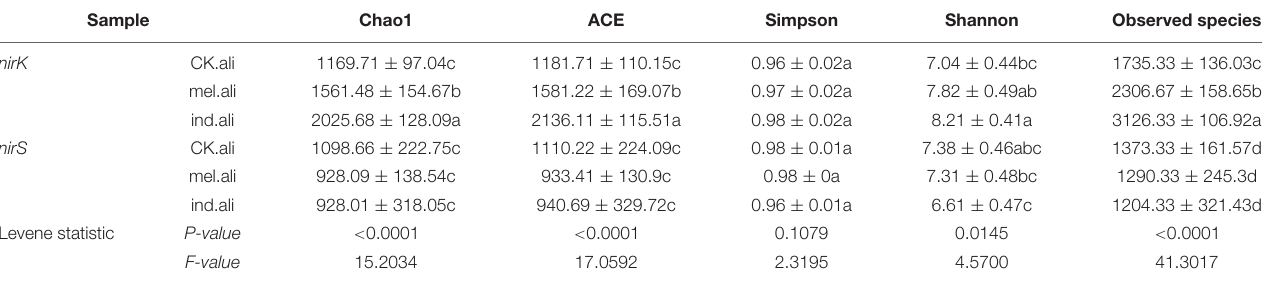
TABLE 3 | Community richness and diversity indices of nirK- and nirS -type denitrifying bacteria in the rhizosphere soil of Quercus aliena with or without Tuber partner. Sample